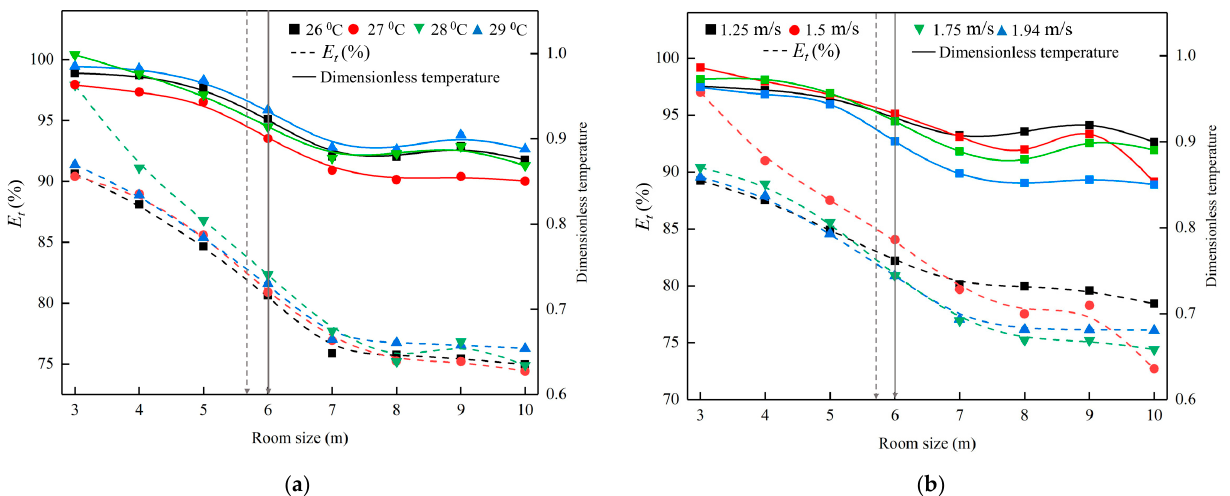
Figure 14. ( a ) The applicable room size dimensions under different air supply temperatures; ( b ) The applicable room size dimensions under different air supply velocity.